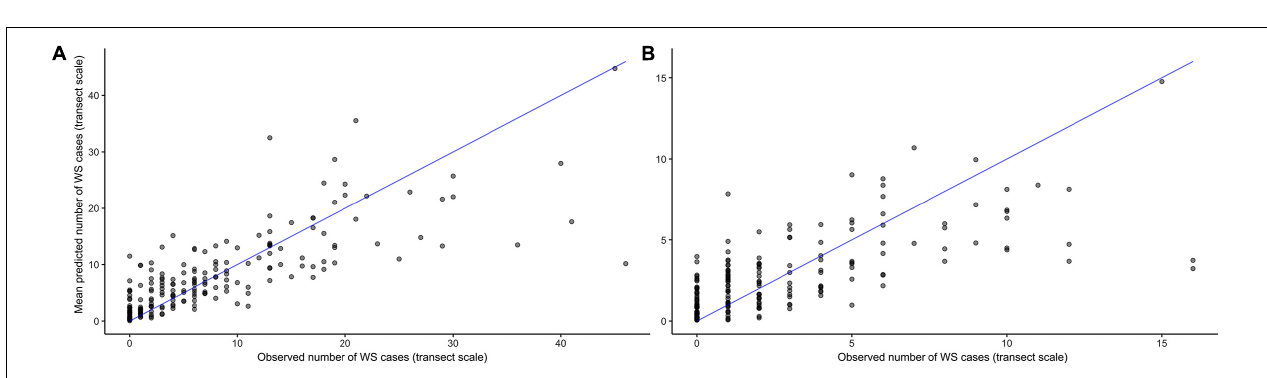
FIGURE 4 | Agreement between observed and predicted White Syndrome cases at the transect scale using 1000 random probability decision rule values for in-sample training data (A) , and out-of-sample testing data (B) . Model predictions tend to underestimate where White Syndrome occurrence is very high.